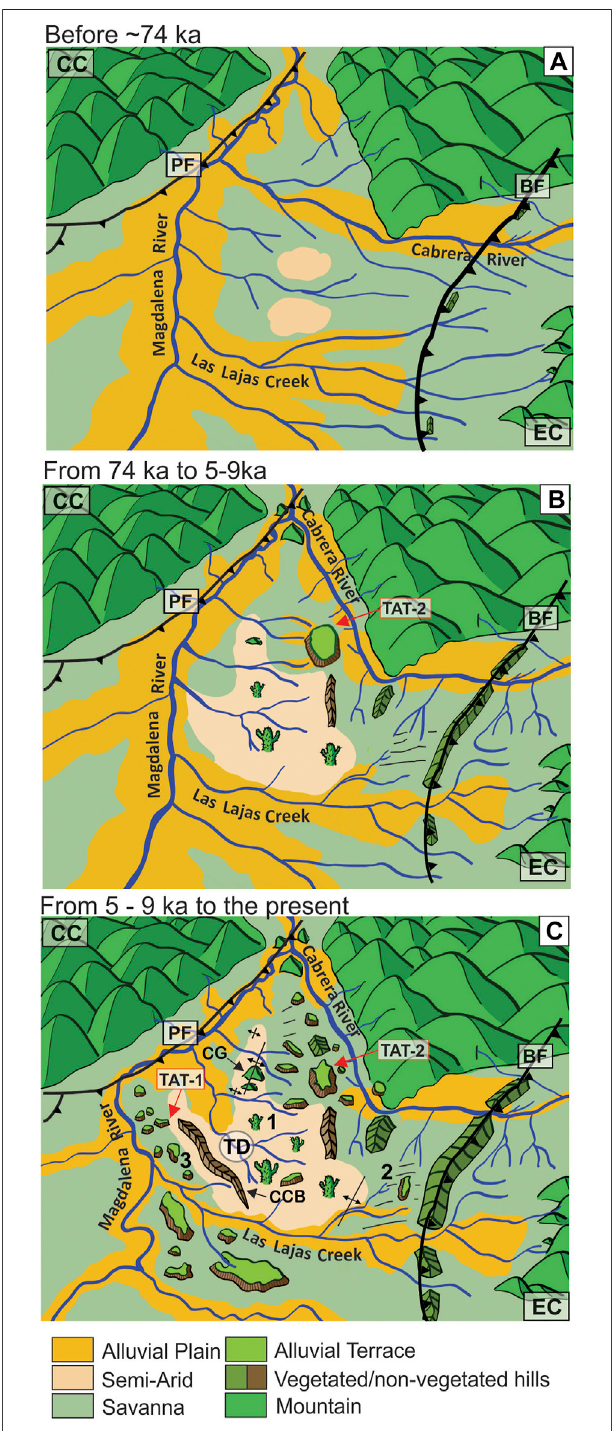
FIGURE 11 | Evolution scheme of the Tatacoa Desert (TD) drainage network. (A) Before ~74 ka. (B) Between 74 ka and 5 – 9 ka. (C) The present times. The formation of the terraces TAT-1 and TAT-2 is shown following the incision of the Magdalena River along the Prado Fault (PF). The shift to the north of Cabrera River and the topographic growth along the Baraya Fault (BF) reduced the drainage area within the TD, restricting sur fi cial water ( Continued )